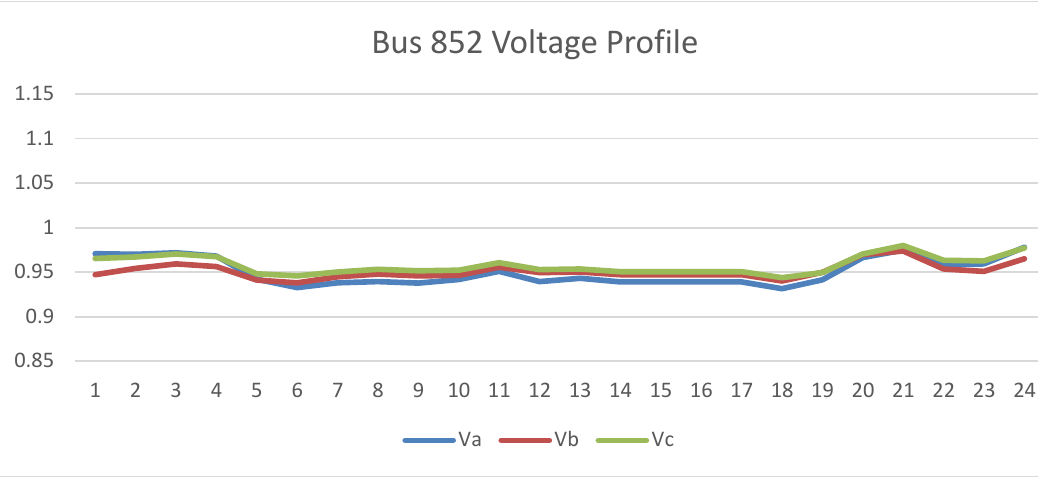
Figure 10. Case 2 Bus 852 Voltage Profile (in Pu) after adding the charging load.